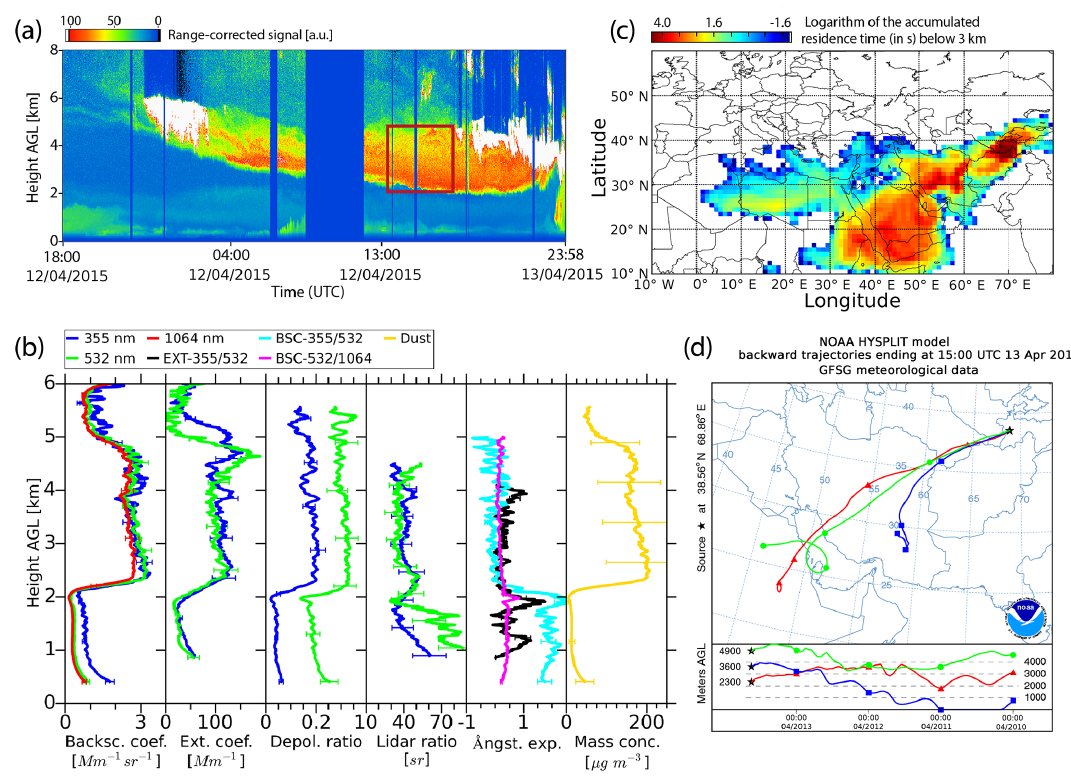
Figure 5. Case 1: a lofted layer of Middle Eastern dust is shown. (a) Same as Fig. 4a, b, c, but on 12 April 2015, 18:00UTC – 13 April 2015, 23:58UTC. (b) The averaged lidar profiles were measured on 13 April 2015, 15:10–16:08UTC. Lidar signals are smoothed before calculation of the extinction-related (743m) and backscatter-related (68m) optical properties. Particle backscatter coefficient at 355, 532, and 1064nm wavelength are shown. Particle extinction coefficient, particle linear depolarization ratio, and lidar ratio at 355 and 532nm wavelength are also shown. Extinction-related Ångström exponent from 355 and 532nm wavelengths (black), backscatter-related Ångström exponent from 355 and 532nm wavelengths (cyan), and backscatter-related Ångström exponent from 532 and 1064nm wavelengths (magenta). Dust mass concentration are shown in yellow. (c) 144h FLEXPART backward trajectories same as in Fig. 4d, e, f, but arriving on 13 April 2015, 14:30–15:30UTC between 2.3 and 4.9km height. (d) 96h HYSPLIT backward trajectories arriving at Dushanbe at 18:00UTC at 2.3, 3.6, and 4.9km